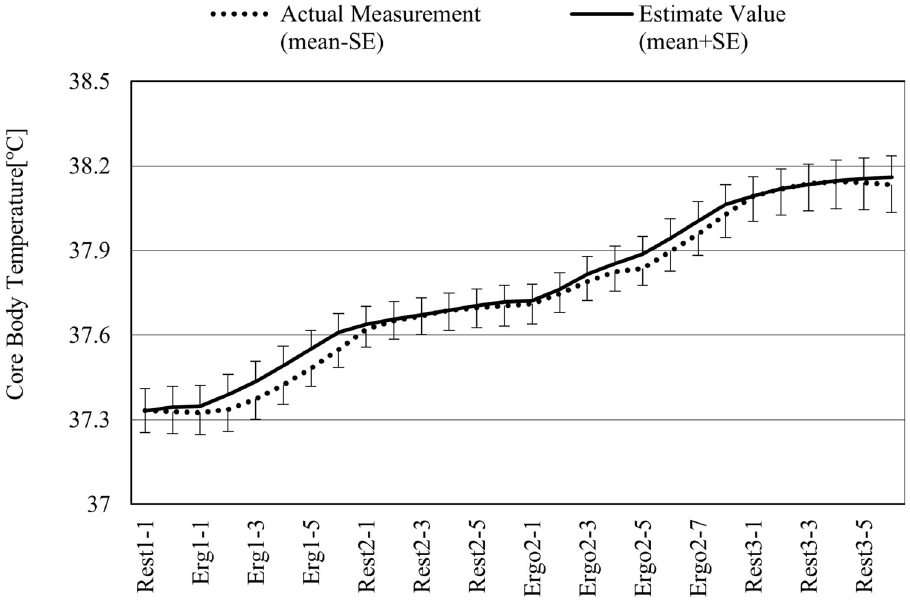
Fig 4. Actual measurements and estimates of core body temperature (average of all test runs). The dotted line shows actual measured values, while the solid line shows estimated values. The mean error was -0.007˚C, while the mean error rate was -0.02%. See S1 Fig for actual measurements and estimates from all 16 test